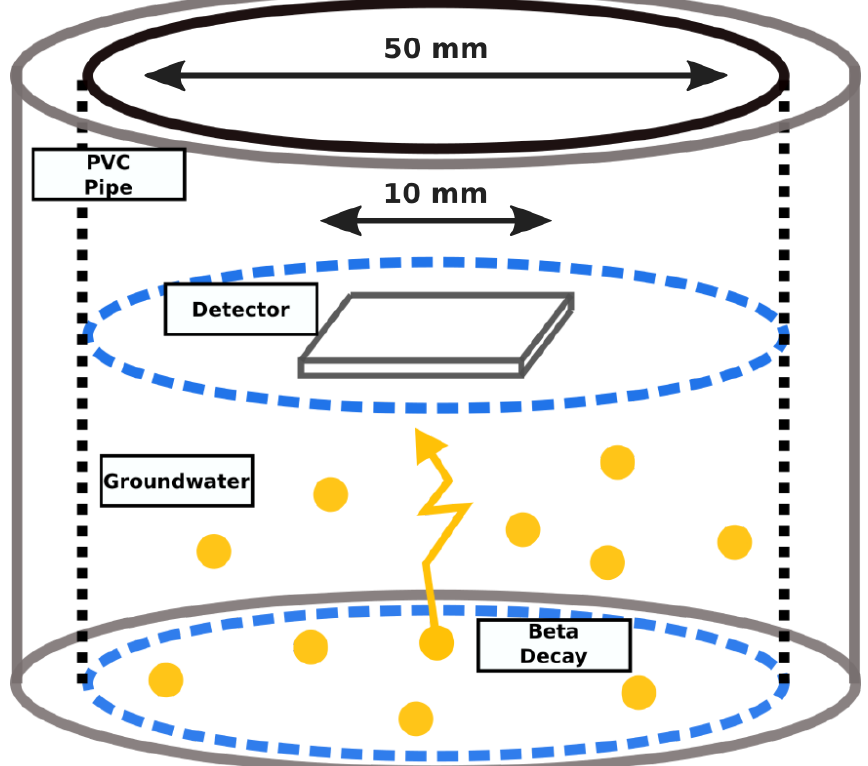
Figure 1. The scenario simulated in the simulation. A PVC pipe, with a 5 cm diameter, comprises the innermost layer of the borehole and it is surrounded by silicon. The detector is deployed in contact with the water, which is populated randomly with decaying